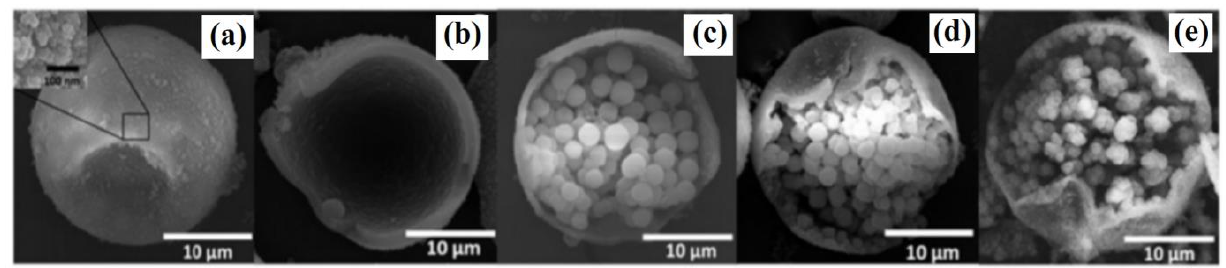
Figure 2. Morphology of microspheres: molecularly imprinted polymers (MIP) ( a ), non-imprinted polymer (NIP) ( b ), and MIP synthesized in various amounts of the template ( c – e ). Adapted with permission from Reference [76]. Elsevier, 2018.